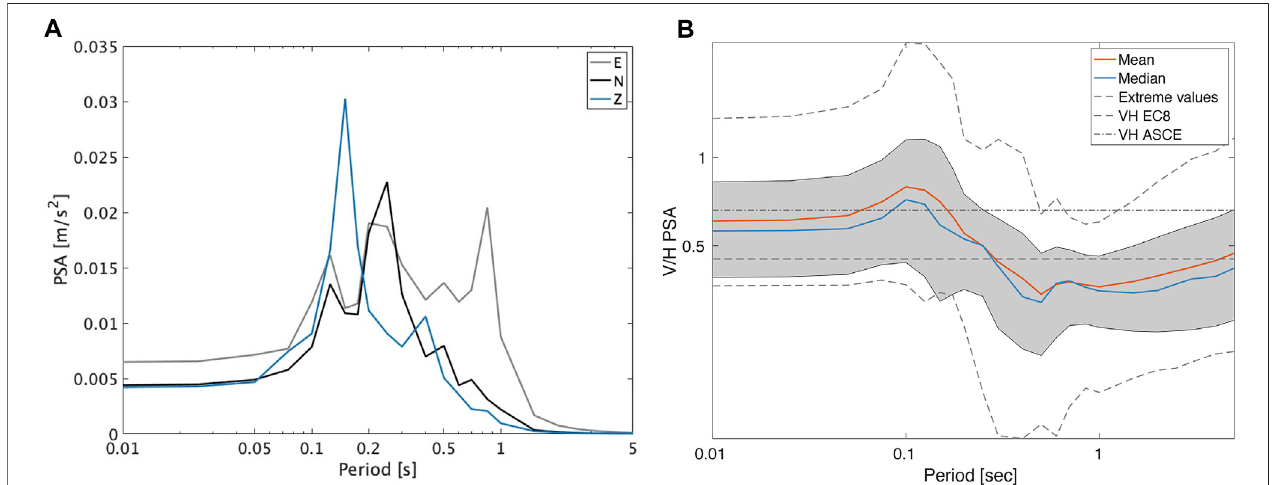
FIGURE8|(A) Example ofaccelerationresponse spectrum forthesurfaceseismometerat station G60from theWesterwijtwerdearthquake ofM=3.4,where the bluelinerepresentsthePSAattheverticalcomponent,thegraylinetheeasternhorizontalcomponentandinblackthenorthernhorizontalcomponent. (B) AveragedV/H from response spectra for each surface seismometer, processing 20 earthquake recordings, at each de fi ned period plotted together with the mean (red) and median (blue)andextremevalues(dashedgray)perperiod.Theshadedareadepictsthemeanplus-minusonestandarddeviation,theblackdashedlineillustratesthe0.45 value as proposed by Eurocode 8 and the dot-dash the 2/3 value proposed by the ASCE.